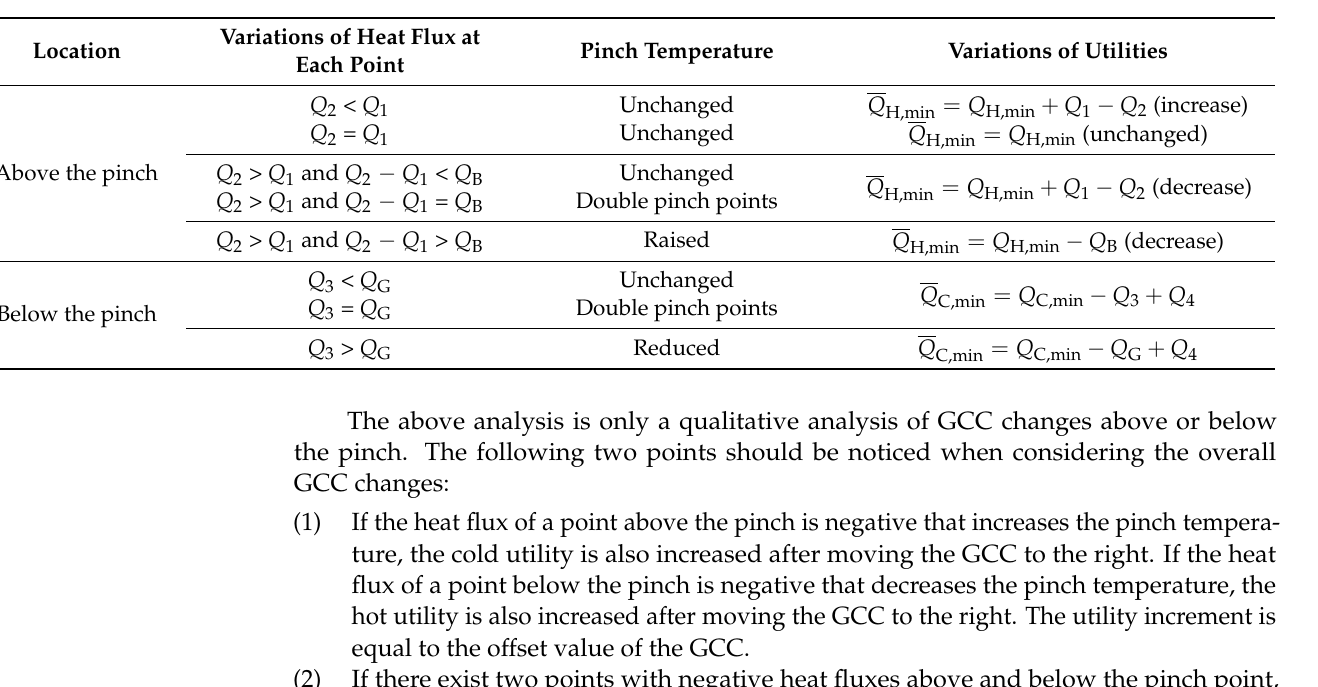
Table 1. Changes of the pinch temperature and utilities for Case